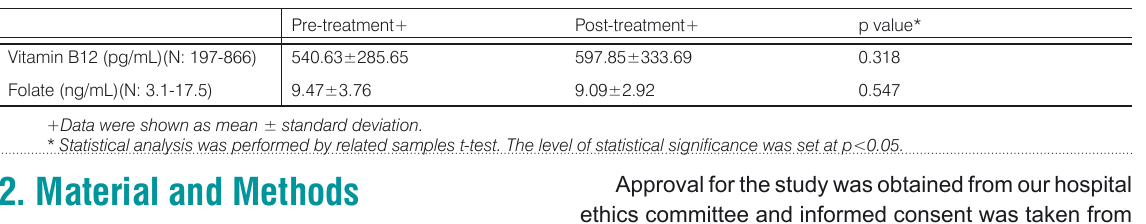
Table 1. Comparison of pre-treatment and 6 months post-treatment folate and vitamin B12